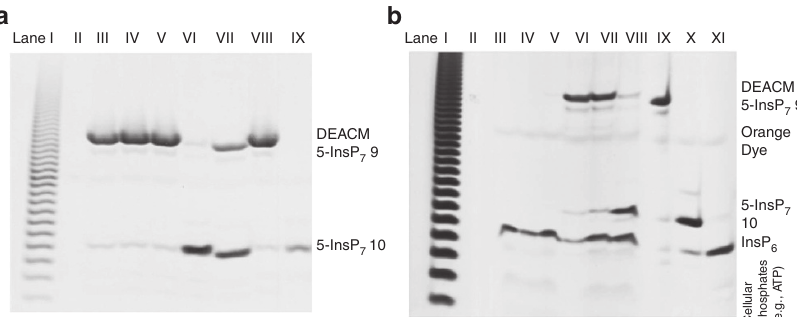
Figure 3 | In vitro and in cellulo release of 5-InsP 7 . ( a ) Analysis of DEACM 5–InsP 7 9 by gel electrophoresis (PAGE) and toluidine blue staining. 9 is stable for hours in rat brain extract (lanes III–V) and can be uncaged by ultraviolet irradiation (lane VI). Lane I: poly-P marker. Lane II: empty. Lane III: 9 in brain extract (3h). Lane IV: 9 in brain extract (2h). Lane V: 9 in brain extract (1h). Lane VI: 9 in brain extract (1h), then ultraviolet irradiation (15min). Lane VII: 9 in distilled water, then ultraviolet irradiation (15min). Lane VIII: 9 . Lane IX: 5-InsP 7 10 . ( b ) Analysis of cellular uptake and in cellulo photouncaging with and without MoTr 11 after TiO 2 microsphere extraction followed by gel electrophoresis (PAGE). Bands containing 9 and 10 were additionally extracted and analysed by MALDI mass spectrometry. 9 only enters cells in the presence of MoTr 11 (lanes VI, VII) and can be uncaged in living cells (lane VIII). Lane I: Poly-P marker to assess quality of separation. Lane II: empty. Lane III: HeLa cells (control). Lane IV: HeLa cells þ 11 (control). Lane V: HeLa cells þ 9 (5h). Lane VI: HeLa cells þ 9 þ 11 (5h), Lane VII: HeLa cells þ 9 þ 11 (16h). Lane VIII: HeLa cells þ 9 þ 11 (16h, then 10min irradiation 366nm, 4W).